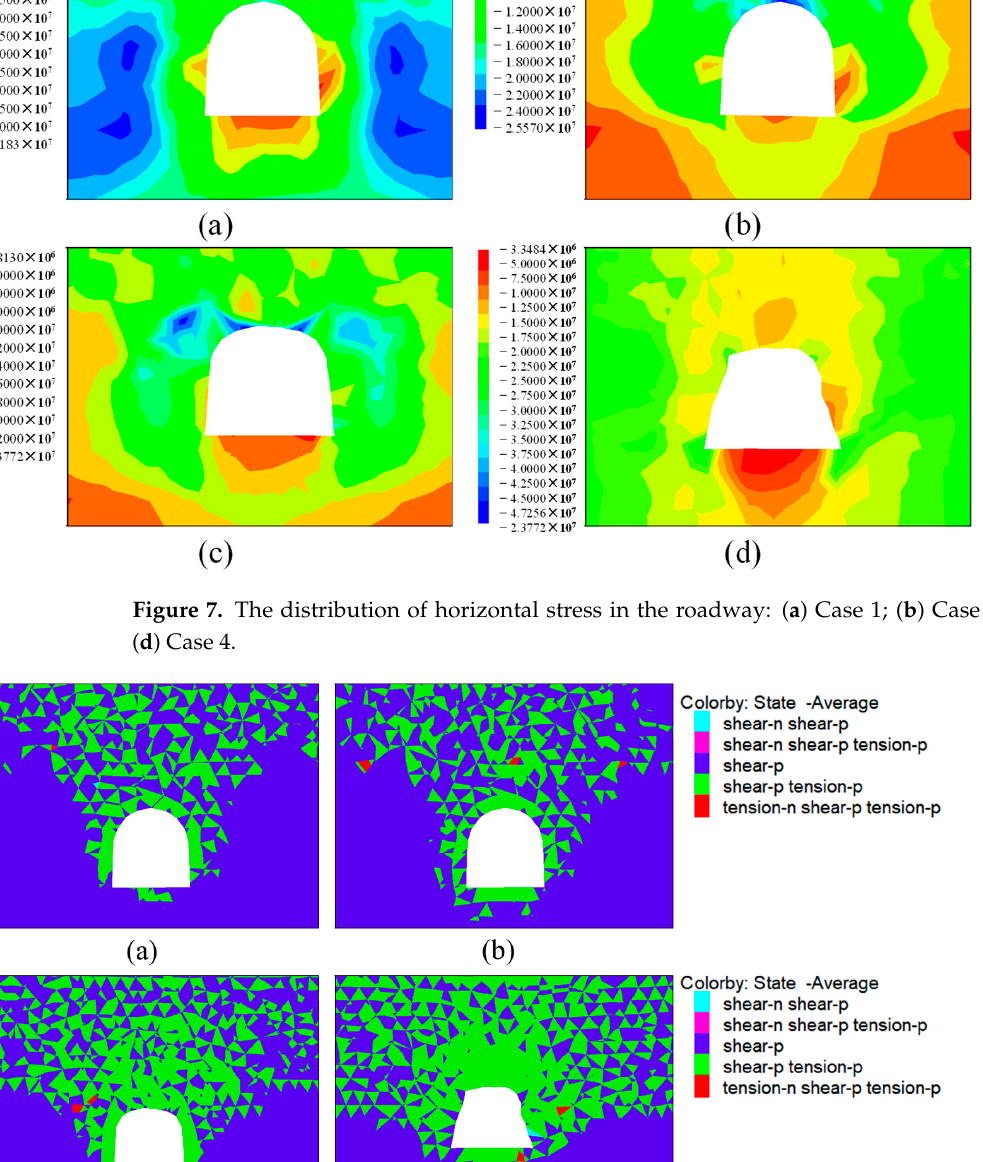
Figure 7. The distribution of horizontal stress in the roadway: ( a ) Case 1; ( b ) Case 2; ( c ) Case 3; ( d ) Case 4.